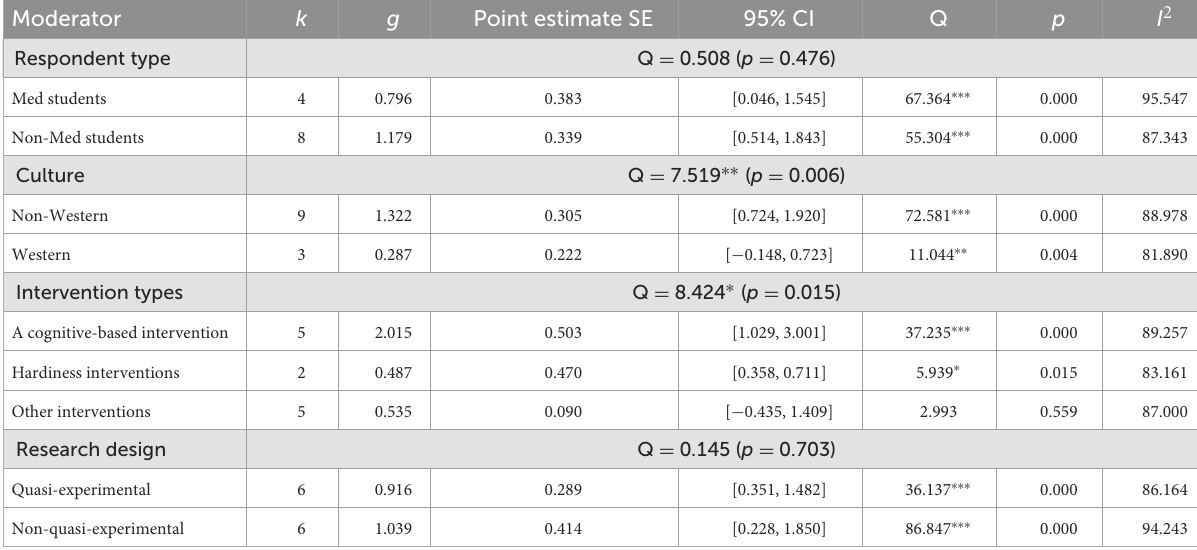
TABLE 3 Subgroup comparison results (categorical